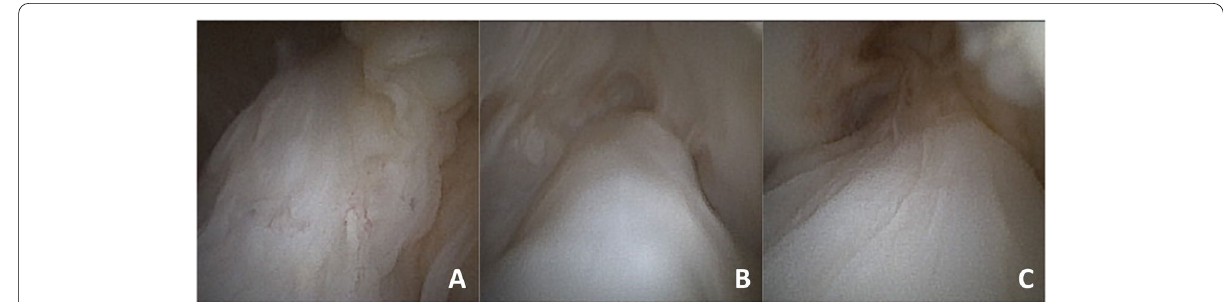
Fig. 3 A , B , C Fair appearance of synovial coverage of the repaired ACL with in-office needle